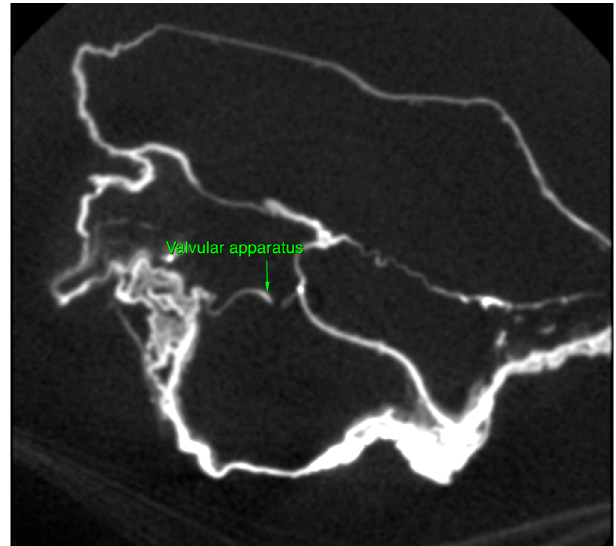
Figure 2. Collapsed heart valve, heart of P. Jaricot .